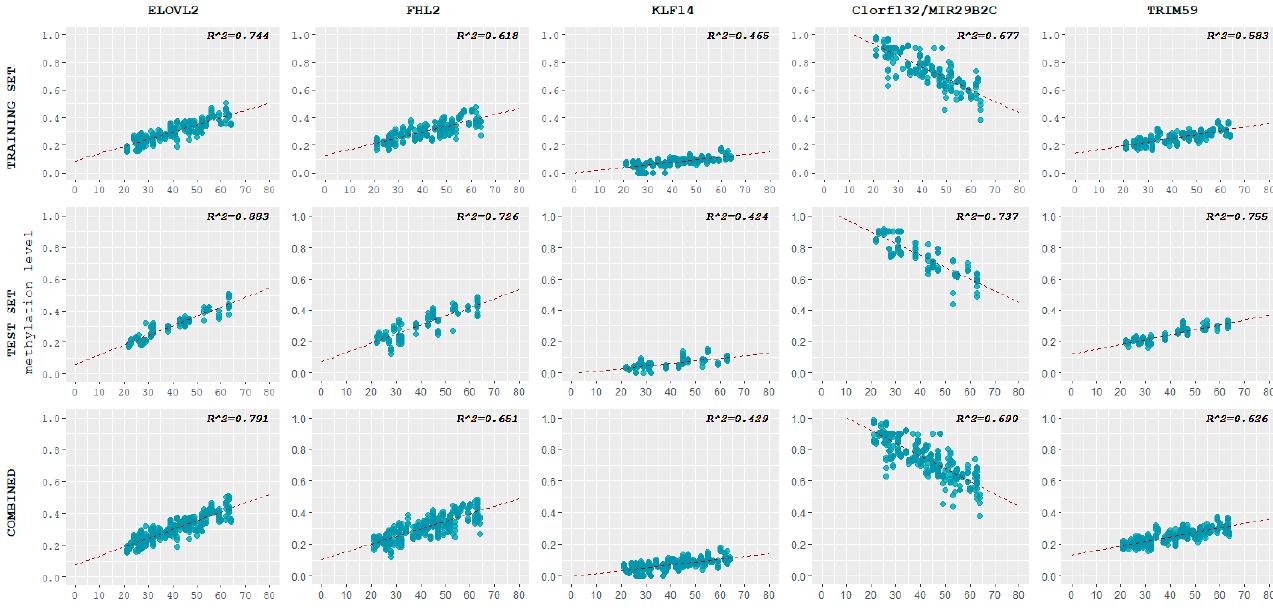
Figure 3. Sca tt erplots displaying the correlation of DNA methylation levels at each of the fi ve loci Figure 3. Scatterplots displaying the correlation of DNA methylation levels at each of the five loci studied with chronological age for all three datasets. studied with chronological age for all three datasets.